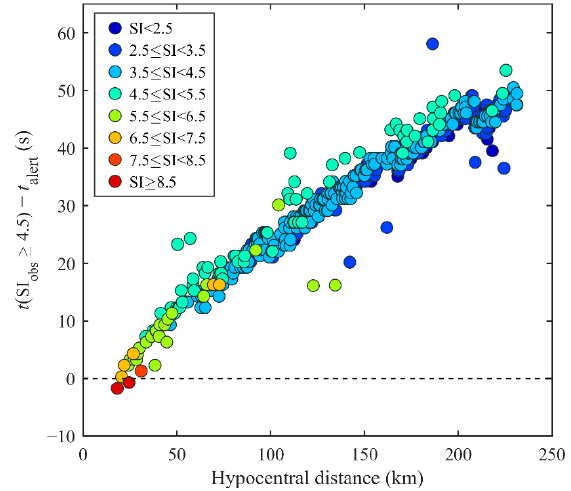
Figure 6. Leading times versus hypocentral distance for the 2022 M 6.1 Lushan earthquake. Times at SI 4.5 are exceeded by the observed shaking intensity at each station, in terms of the time when the site is alerted. This is equal to the leading time. Each station is plotted with a specified color accord- ing to its observed intensity. Leading times presented in this figure do not include early-warning message transmission delays, and therefore represent the maximum values.